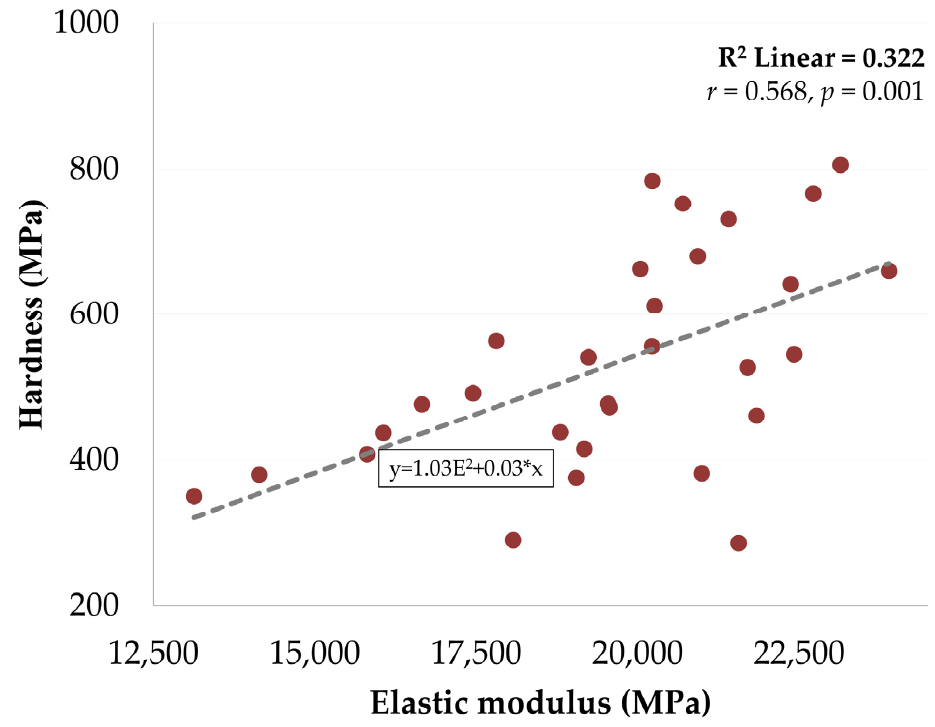
Figure 2. Pearson correlation test results showing significant ( p < 0.05) and strong ( r > 0.5) linear relationship between the Hardness and Elastic modulus values (in MPa) as demonstrated by hydrated (tested after 5 m of removal from storage) and dehydrated (tested after 1 h and 24 h of dehydration) human dentin beams.